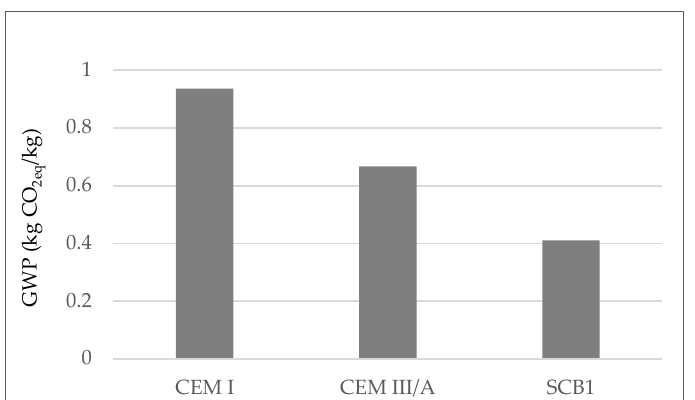
Figure 2. GWP according to LCA of OPC; CEM I, a cement where 35–64% of the clinker is replaced with blast furnace slag; CEM III / A, a simulated cement where 55% of the clinker is replaced with MSWI FA.